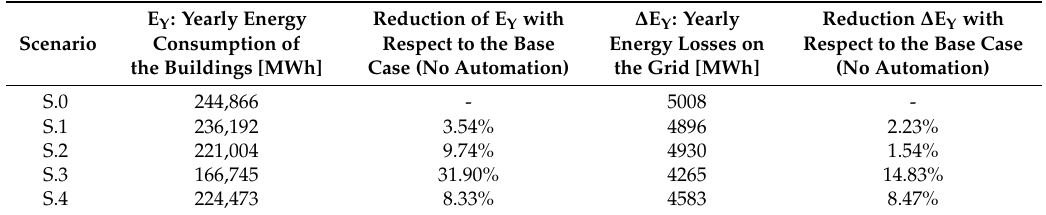
Table 9. Palermo–Energy consumptions and losses for the different control logics (Presence of FV)